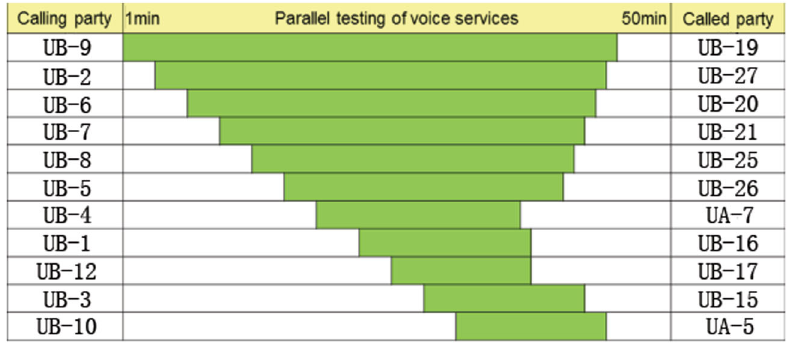
Fig. 3 Twenty-two users simultaneously make calls with QKD protocols. The green areas represent the duration over which users make